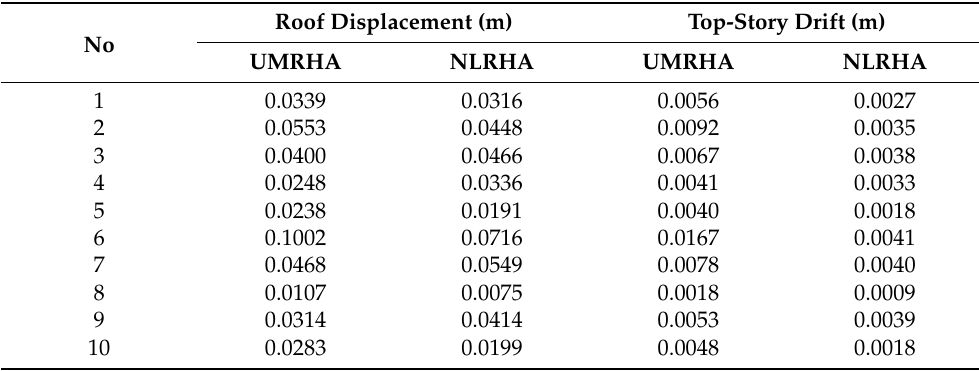
Table 11. Peak values regarding roof displacement and top-story drift of RES open ground-story frame to the selected ground motions.